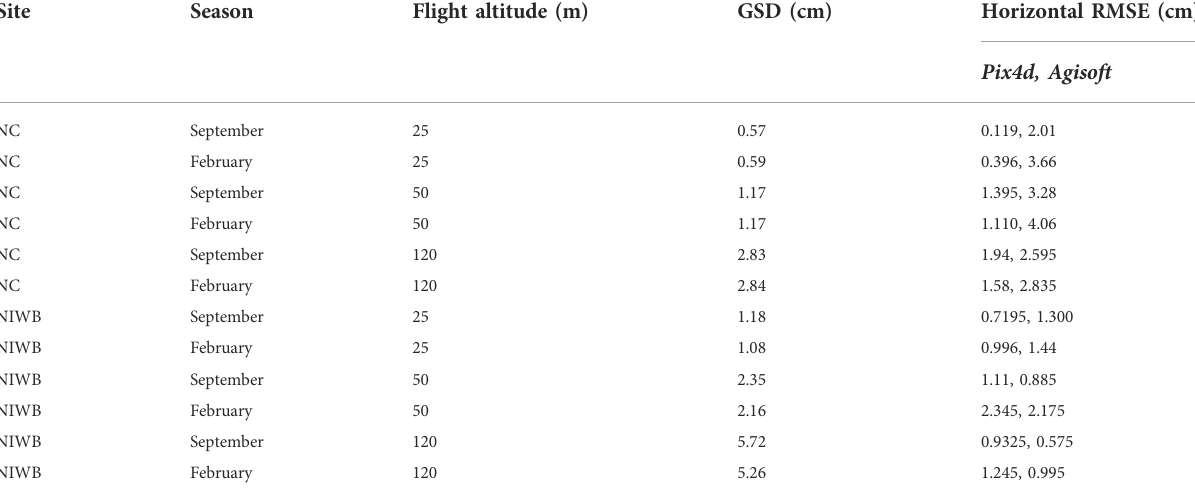
TABLE 2 Ground ControlPoint(GCP)reprojectionerrorintheXYplaneissimilar( < 5 cm)acrosssoftwares,altitudes,and sites.RMSE erroriscalculatedasthe average of reported X and Y RMSE. Horizontal RMSE is computed in SfM softwares by comparing of GNSS-recorded GCP (n = 5 – 12) positions with SfM- computed GCP positions. GNSS recorded positions are recorded with less than 1 cm of horizontal error.